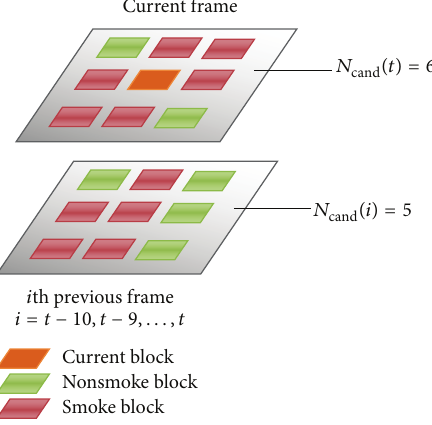
Figure 2: The calculation process of the spatiotemporal consistency